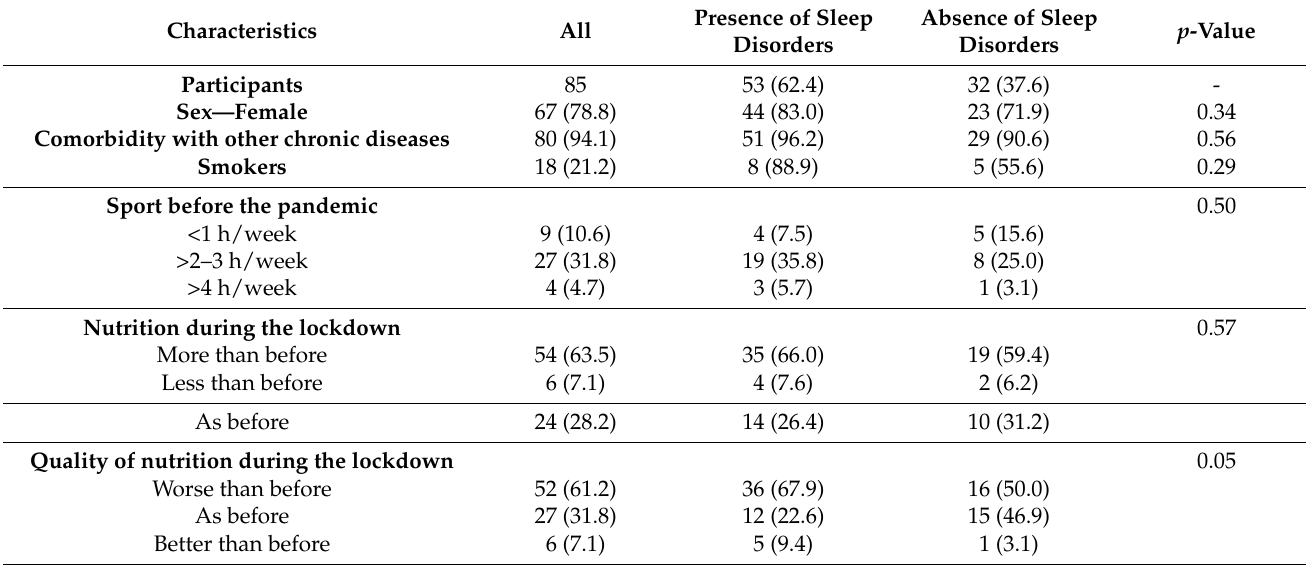
Table 3. Main cohort characteristics by sleep disorders. Significant differences are in